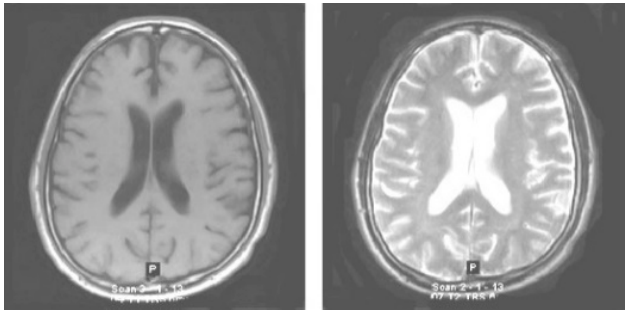
Figure 2. Original normal brain T1-weighted and T2-weighted MRI images.